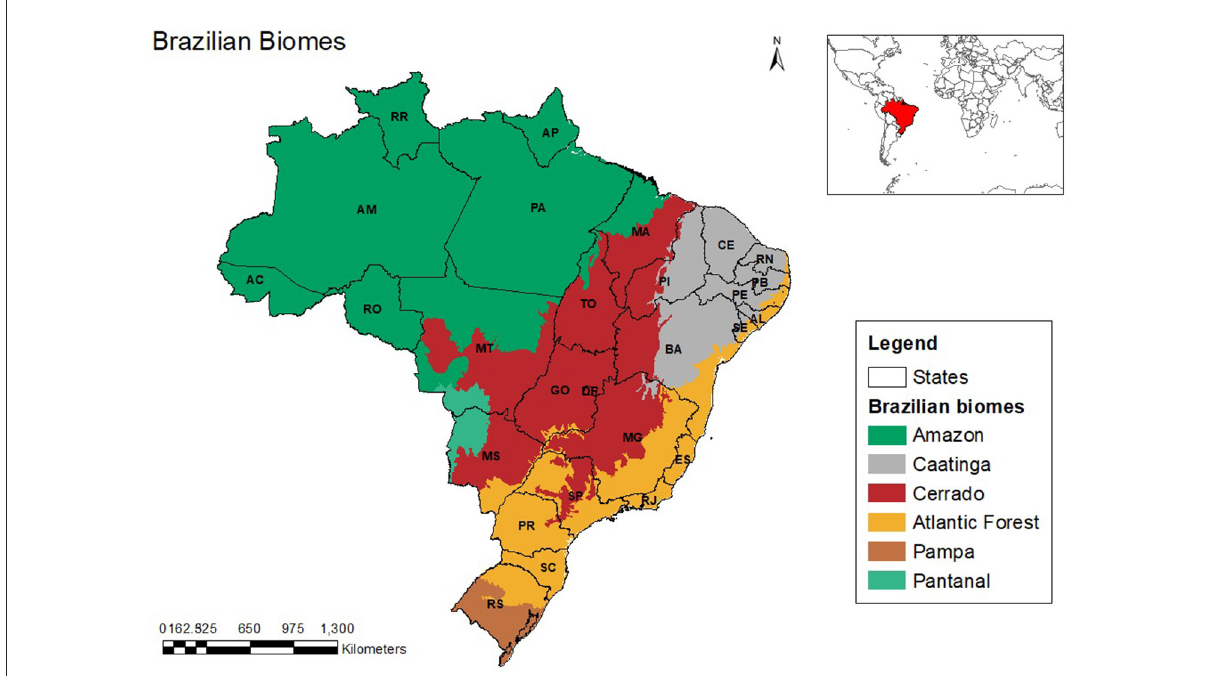
FIGURE1 Brazilian biomes: Amazon, Caatinga, Cerrado, Atlantic Forest, Pampa, and Pantanal. Data sourced from IBGE